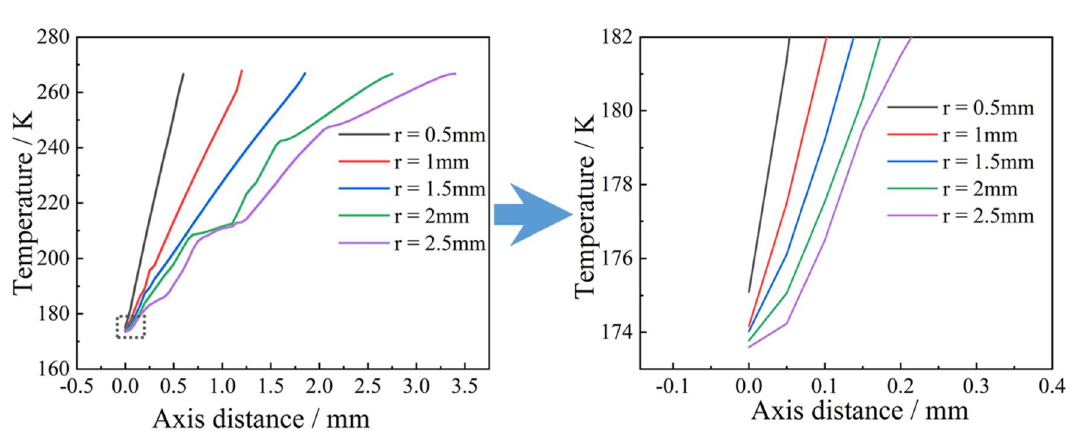
Figure 14. Temperature at the axis of the droplet at 267 K at